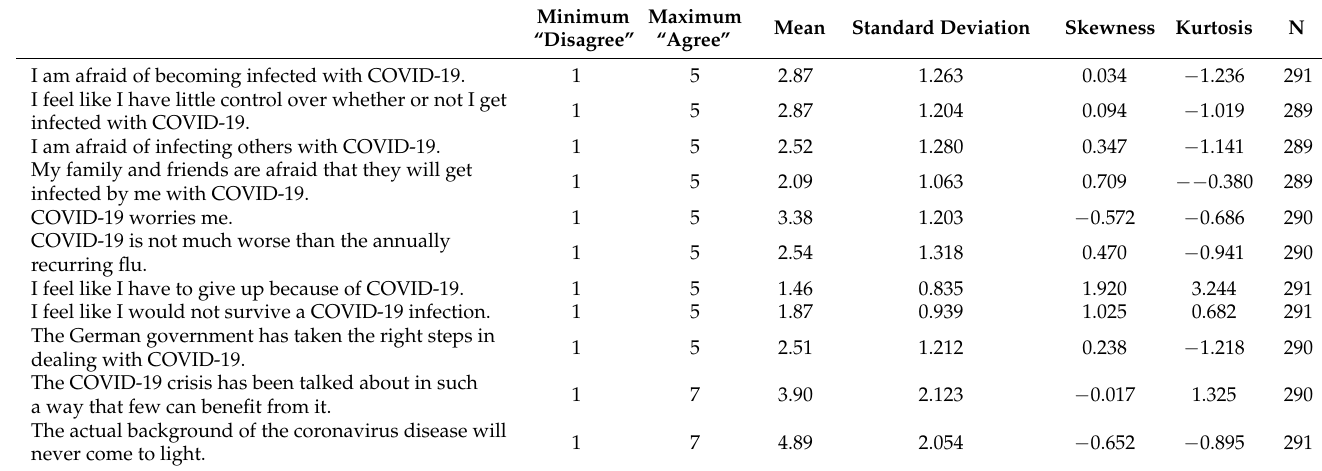
Table A2. Descriptive statistics of variables to measure attitudes to COVID-19 (measured in